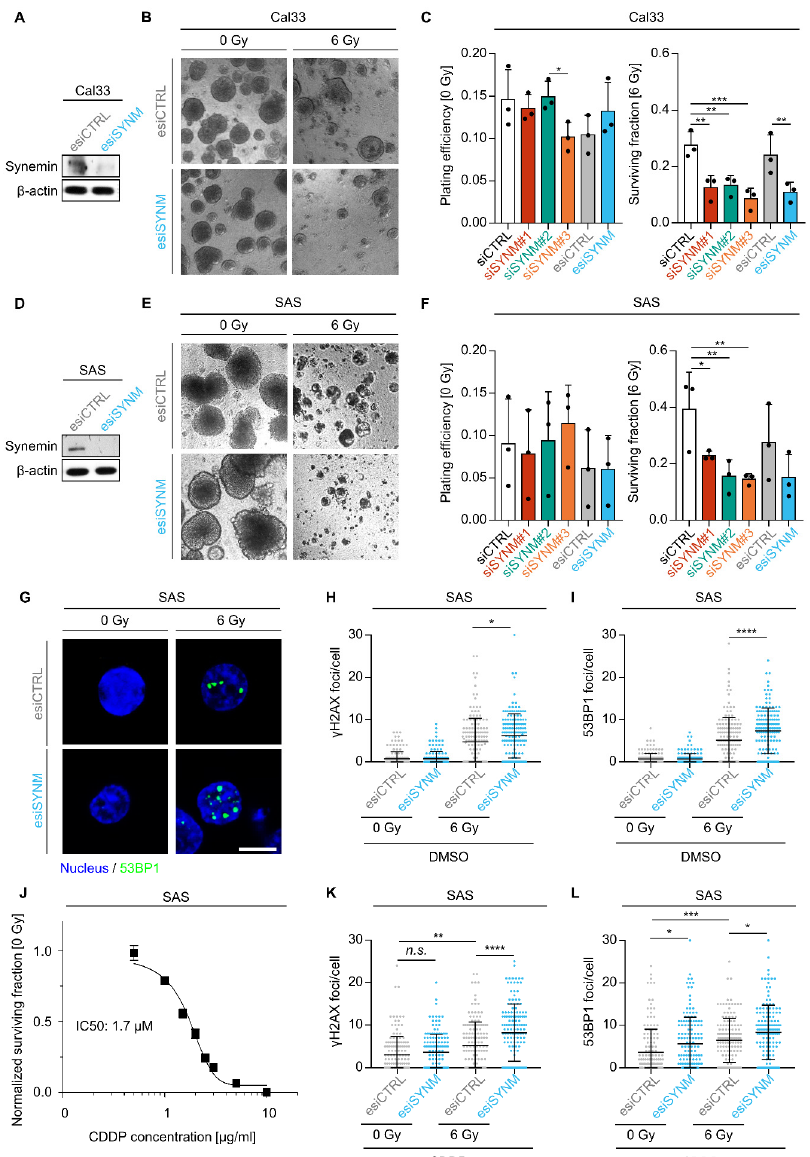
Figure 1. Synemin essentially controls cellular radiochemosensitivity of 3D lrECM HNSCC cell cultures. ( A ) Knockdown efficiency of control and synemin-specific esiRNA in whole cell lysates from Cal33 cells. ( B ) Representative phase contrast images of 3D lrECM Cal33 cell cultures (bar, 200 µm). ( C ) Plating efficiencies of un-irradiated Cal33 cells and surviving fraction of Cal33 cells after 6 Gy X-ray exposure ( n = 3). Dots represent the mean of each independent experiment. ( D ) Knockdown e ffi ciency of control and synemin-specific esiRNA in whole cell lysates from SAS cells. ( E ) Representative phase contrast images of 3D lrECM SAS cell cultures (bar, 200 µ m). ( F ) Plating e ffi ciencies of un-irradiated SAS cells and surviving fraction of SAS cells after 6 Gy X-ray exposure ( n = 3). Dots represent the mean of each independent experiment. Data are presented as mean ± SD (two-sided t -test; * p < 0.05, ** p < 0.01, *** p < 0.001). ( G ) Representative immunofluorescence images of 53BP1 foci (green) and nucleus (DAPI, blue) (bar, 10 µ m). ( H ) γ H2AX and ( I ) 53BP1 residual foci numbers upon synemin inhibition plus / minus X-ray exposure. ( J ) Dose-response relationship of SAS cells treated with increasing Cisplatin (CDDP) concentrations ( n = 3; IC50, inhibitory dose at 50% survival). ( K ) γ H2AX and ( L ) 53BP1 foci numbers upon synemin inhibition and CDDP treatment in combination with and without 6-Gy irradiation ( n = 3; at least 50 cells were quantified per condition per trial). Data are presented as mean ± SD (one-way ANOVA followed by post-hoc analysis using Tukey’s correction; * p < 0.05, ** p < 0.01, *** p < 0.001, **** p <